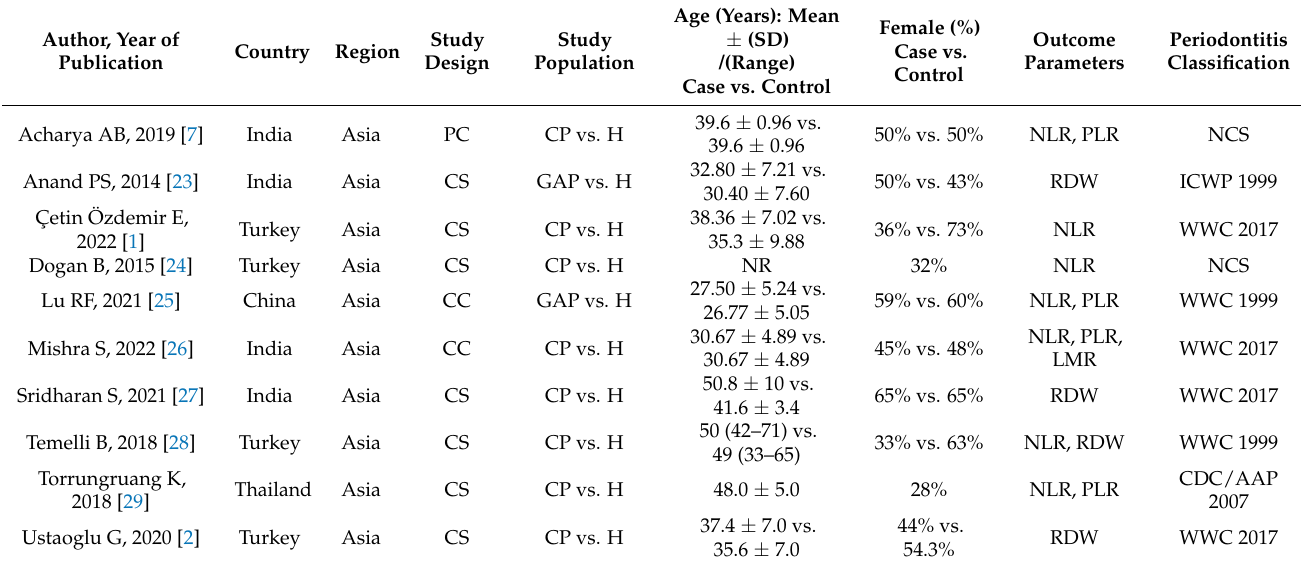
Table 1. Characteristics of the included studies.